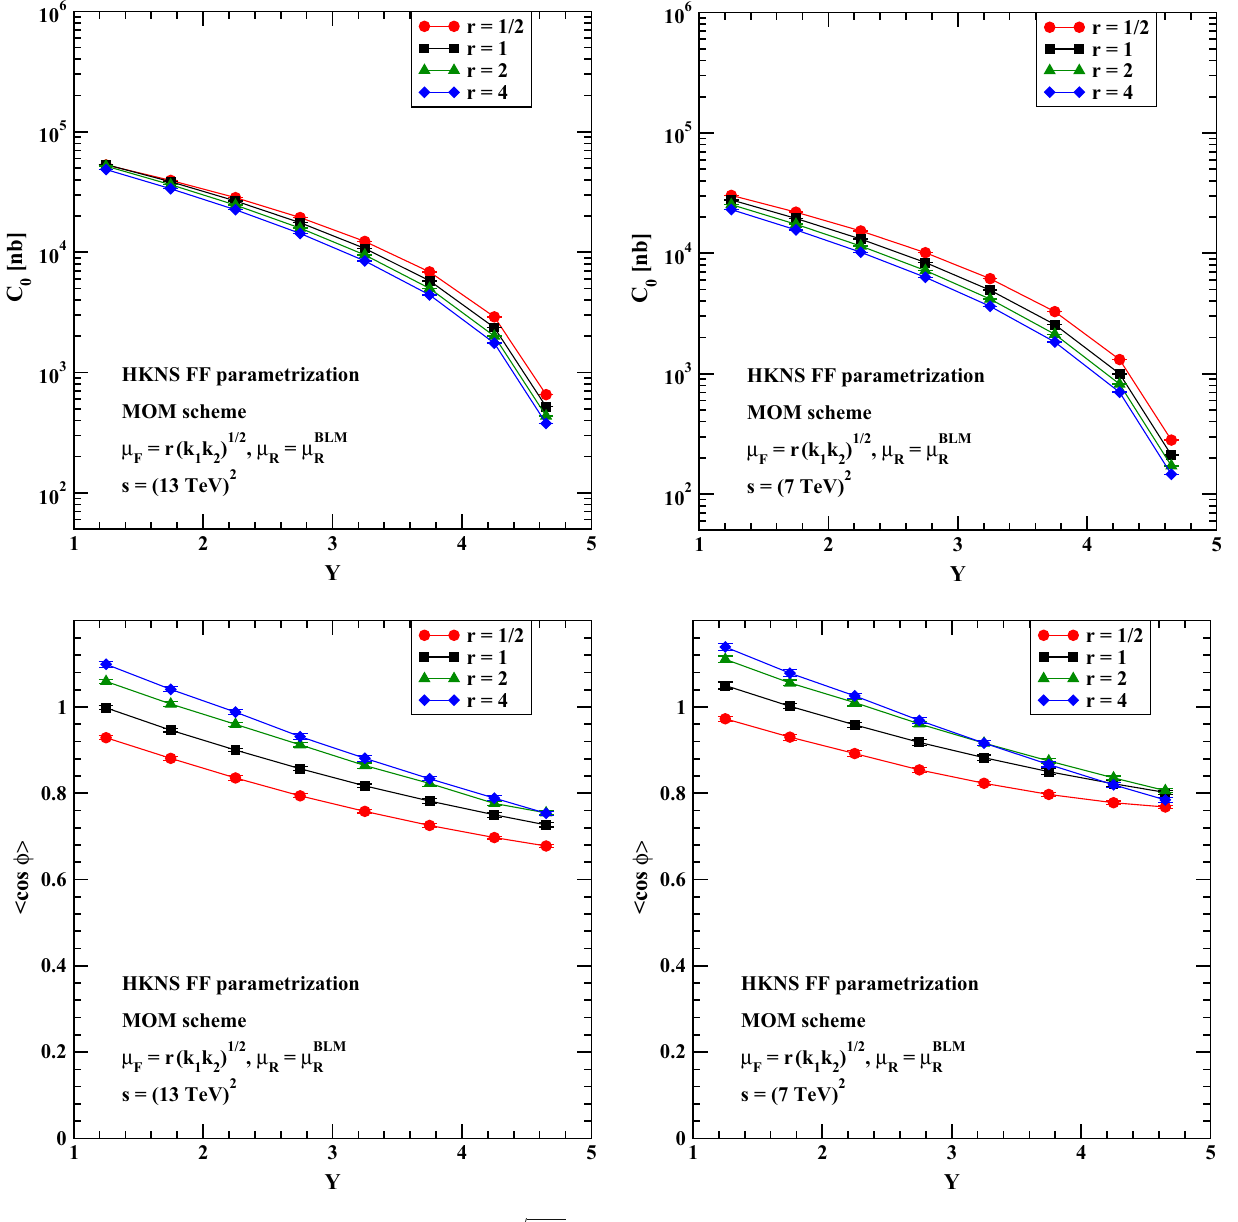
Fig. 12 Y -dependence of C 0 and of C 1 / C 0 for (μ F ) 1 , 2 = r mass energy of 7 and 13 TeV for the rapidity region Y ≤ 4 .